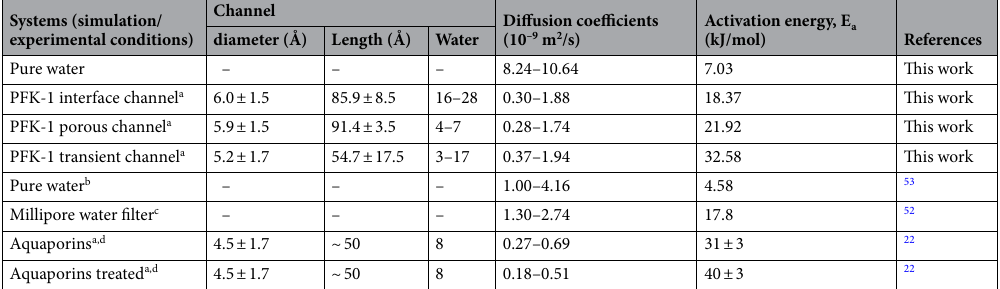
Table 2. Self-diffusion constants of different confinement water dynamics by temperature. a The channels were computed using MOLE online 46 for PFK-1 (PDB entry 1PFK) and Aquaporins (PDB entry 2ABM), excluding ligands, and E a was calculated at 290 K. b The self-diffusion coefficients of liquid water in the temperature range 273–325 K were determined by both the capillary method and the usual diaphragm cell method with deuterium as tracer. c Experimental data are from the self-diffusion coefficients of a millipore filter diaphragm cell of water in the temperature range 278.2–308.2 K. d The Arrhenius plots of the logarithm of D ef versus 1/T of both control and HgCl 2 -treated roots had linear portions between 293 and 283 K and between 298 and 308 K. E a values obtained from the slopes of linear portions of the graphs differed at 293–303